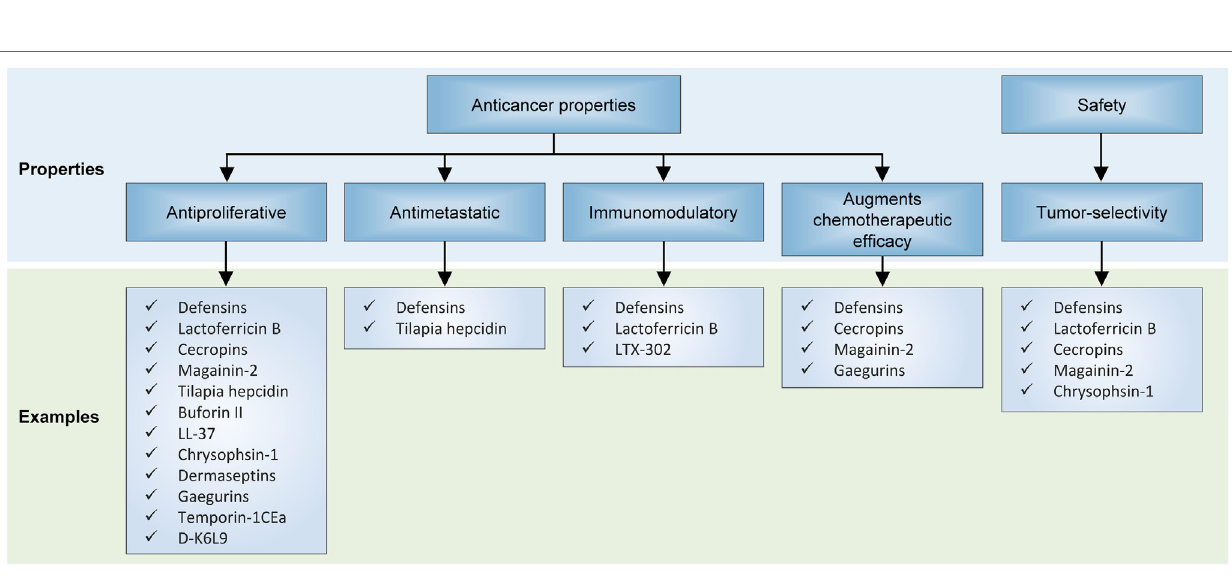
FiGURe 4 | Effects of antimicrobial peptides on in preclinical models of neoplasia. Several recurrent themes have emerged from unfolding research on their anticancer properties, including their antiproliferative and antimetastatic capabilities, invigoration of antitumor immunity, activity against multidrug-resistant cancer cells, and selectivity for cancer cells but not normal cells.